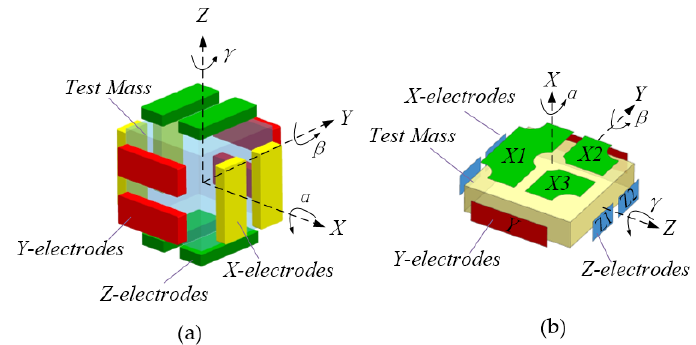
Figure 3. Schematic diagram of the electrode configuration. ( a ) Electrode arrangement of each axis under the average degree of freedom; ( b ) Electrode arrangement of each axis under the non-average degree of freedom.